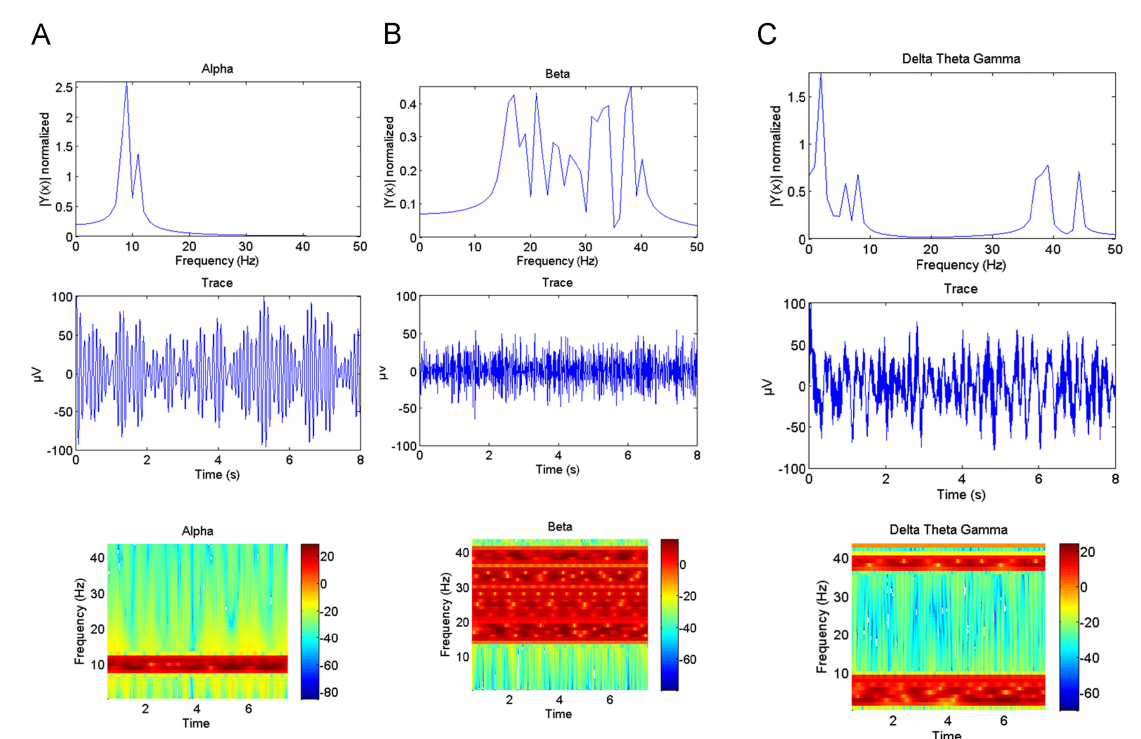
Figure 11. Example of spectral analysis of an artificial EEG containing alpha (A), beta (B) and delta theta gamma sub-bands (C). A color-code is used for the representation of spectral densities (bottom panels). Note the red bands corresponding to the highest spectral